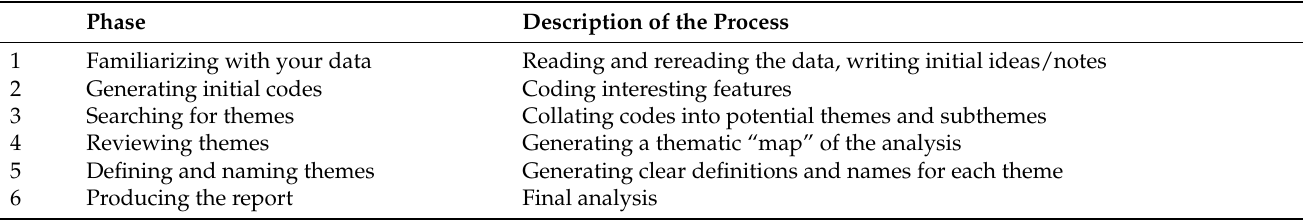
Table 2. A schematic view of Braun and Clarke’s six-phase framework for thematic analysis